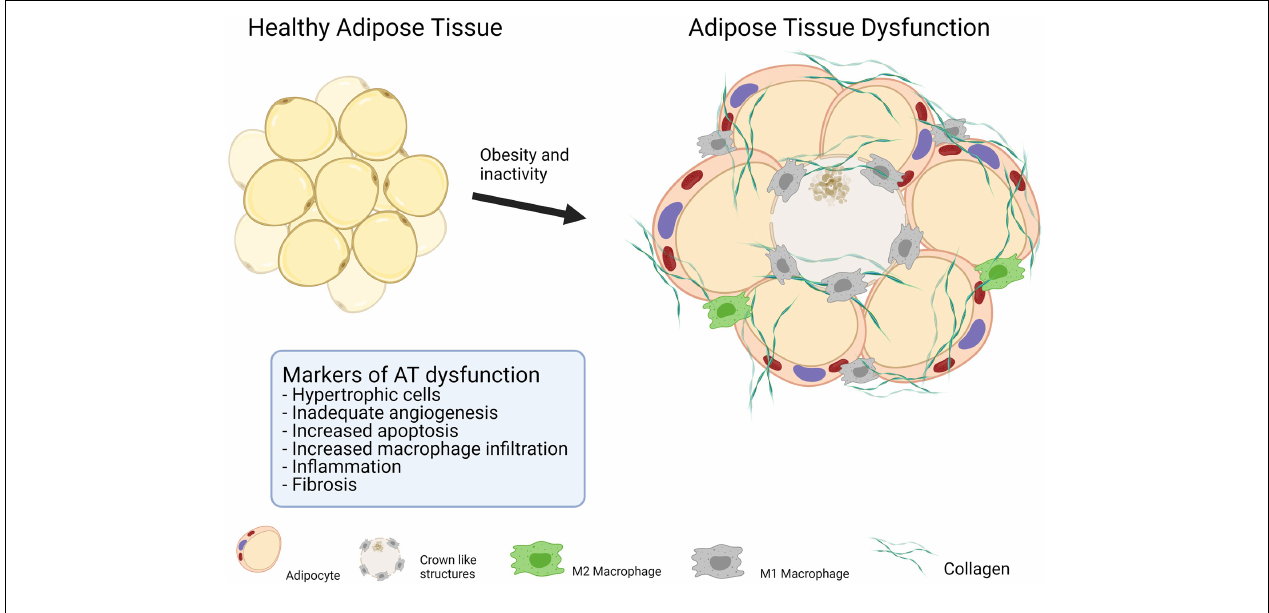
FIGURE 2 | Makers of adipose tissue